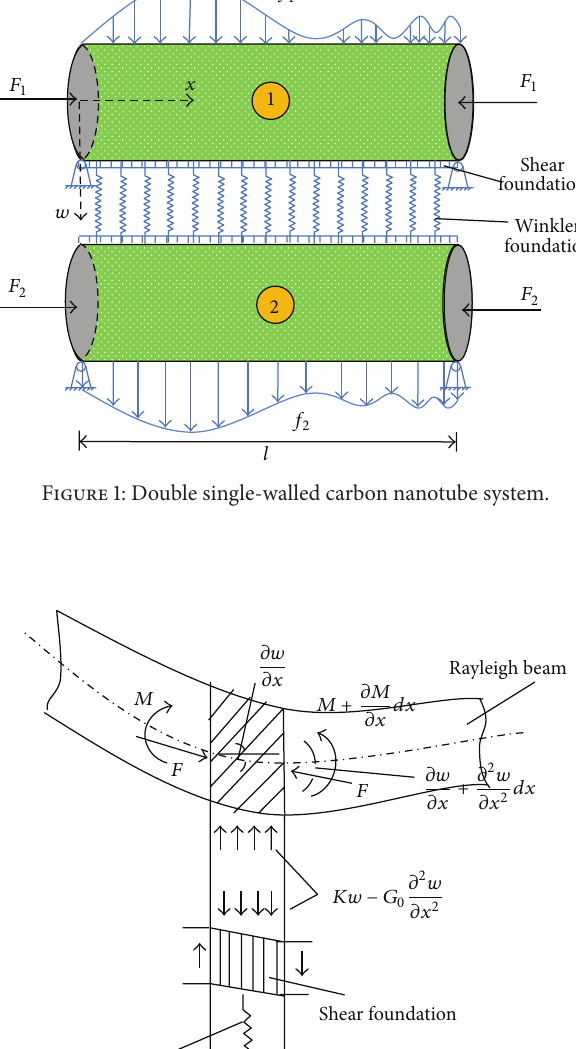
Figure 2: Deflected differential Rayleigh beam element with Paster- nak layer